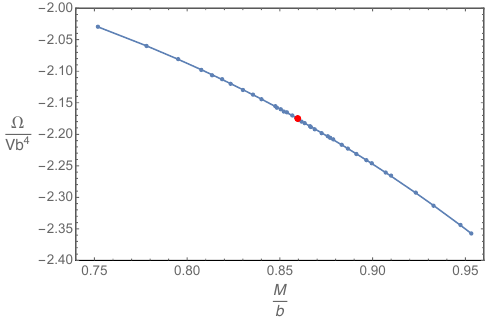
Figure 3 . The free energy density as a function of M/b across the critical point (the red dot). The free energy density is continuous and smooth during the topological quantum phase